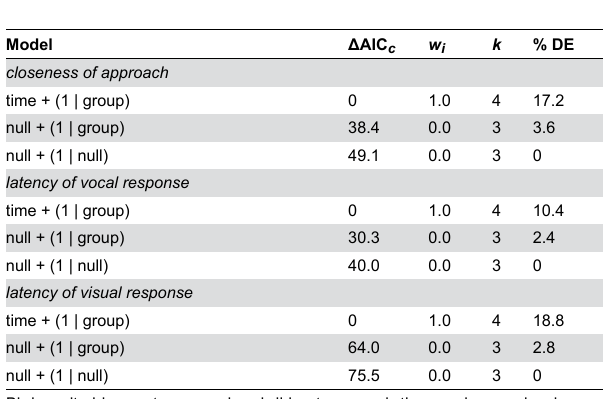
Tables 3. Evidence for habituation in five Plain-tailed Wren Thryothorus euophrys groups that experienced playback once a day for 20 days.